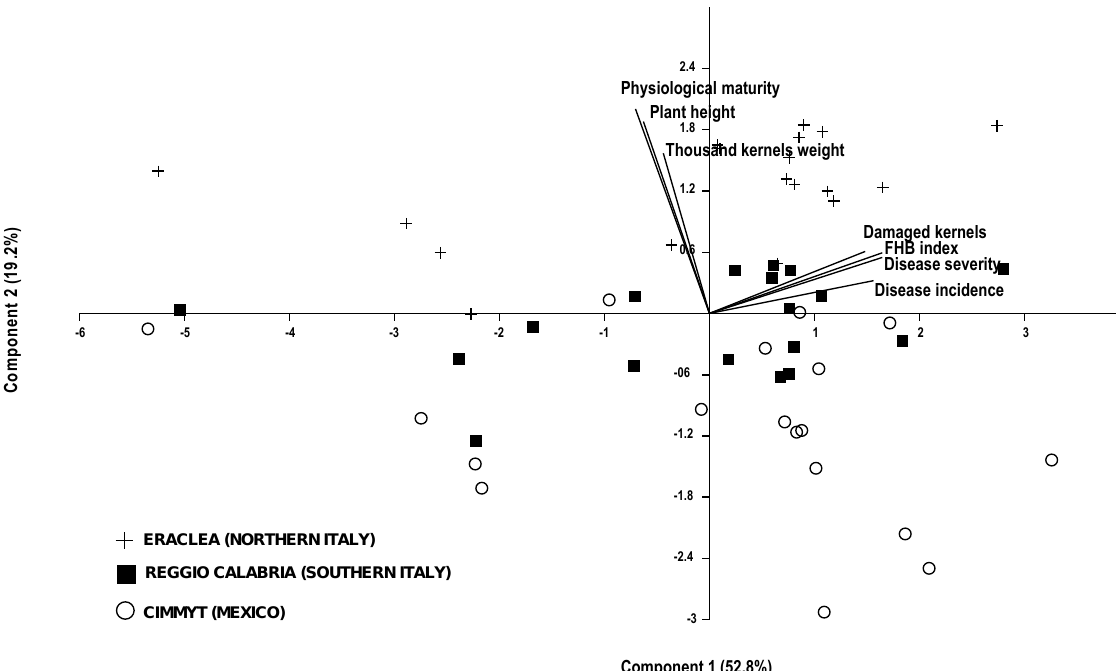
Figure 2. Principal component analysis (PCA) biplot. Cultivar scores are grouped by site (Eraclea, Reggio Calabria and CIMMYT); vectors represent seven variables, including four disease susceptibility indices as well as three morpho- physiological and grain qualitative